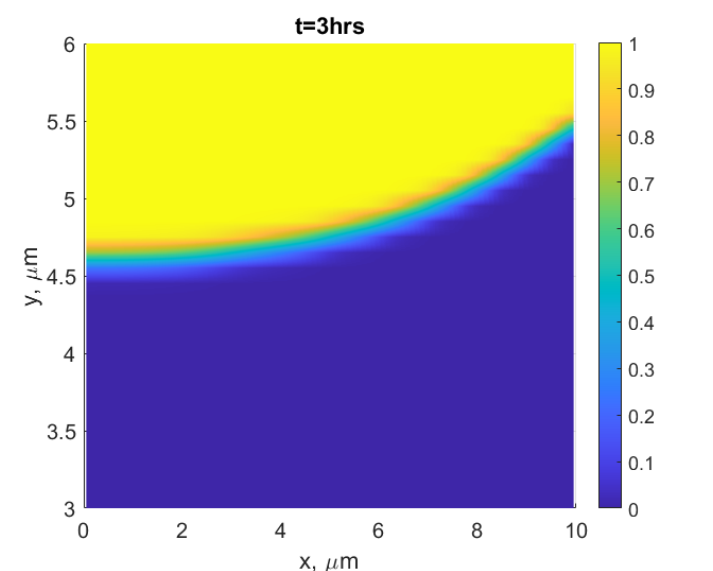
Figure 2. Plot of variable φ shows bent grain boundary near the surface due to